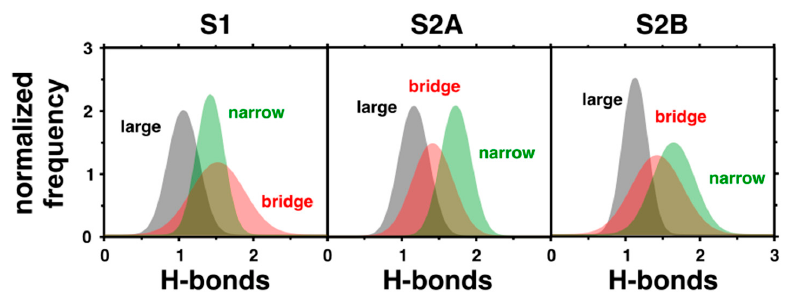
Figure 3. Hydrogen bonds per water molecule in the three different water channels computed in states S 1 , S 2A , and S 2B . The presented histograms account for the normalized frequency of occurrence of different hydrogen bonds per water.